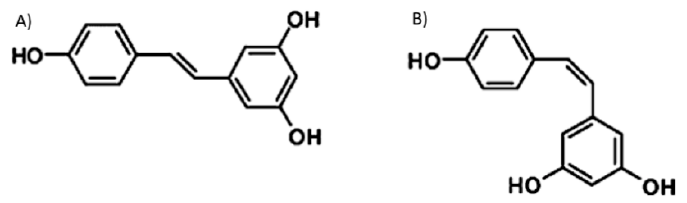
Figure 1. Chemical structures of ( A ) trans- and ( B ) cis-